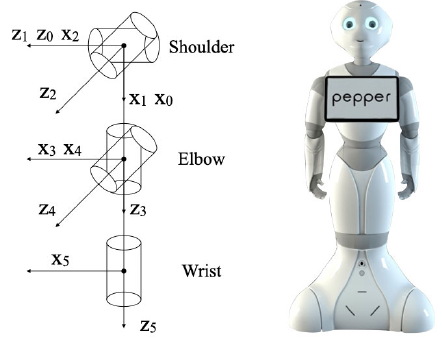
Figure 8. The humanoid robot Pepper and its arm configuration.